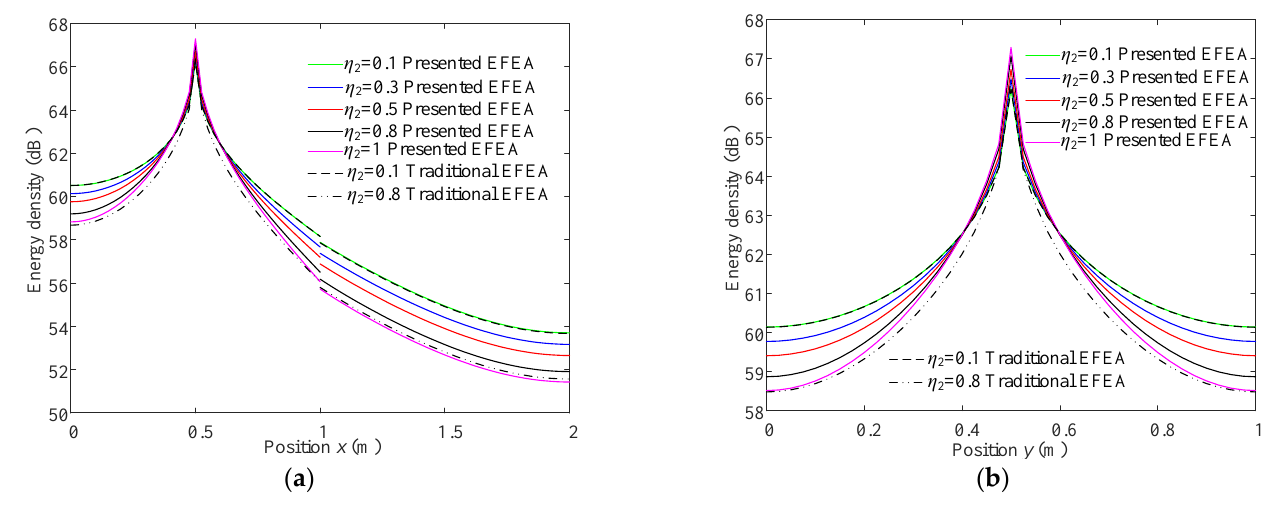
Figure 11. Energy density distribution for a plate with PFLD treatment of various loss factor of damping layer ( f = 3 kHz, h 2 = 0.003 m). ( a ) Energy density distribution at y 0 = 0.5 m. ( b ) Energy density distribution at x 0 = 0.5 m.